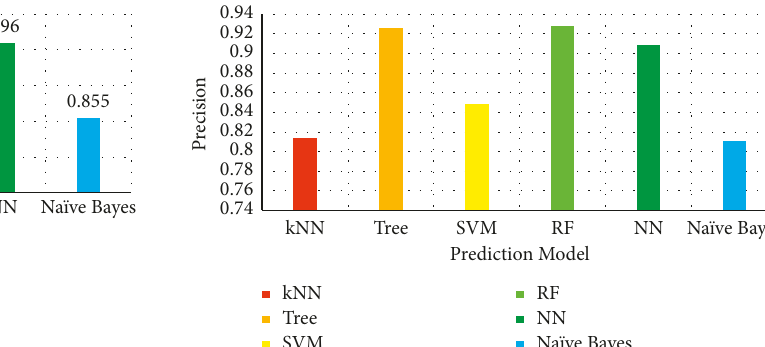
Figure 9: The AUC of all ML models.